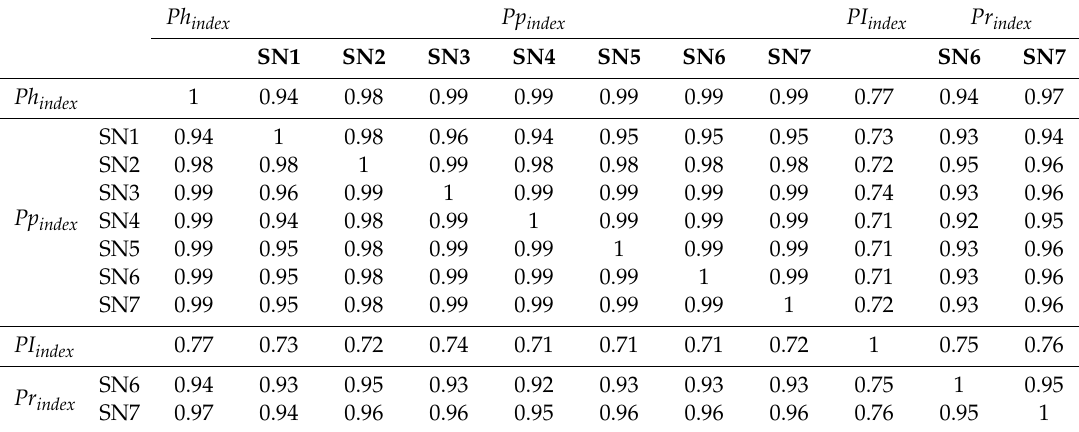
Table 6. PCCs among the quality indices.